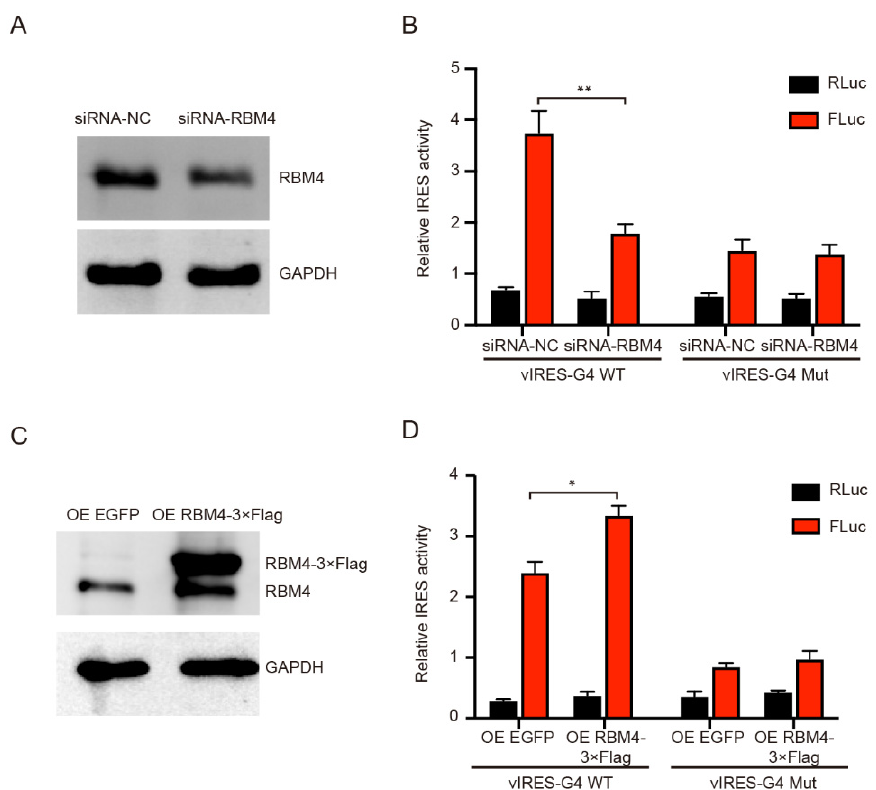
Figure 4. Effect of RBM4 on the expression of luciferases. ( A ) Western blot analysis of RBM4 protein after RNAi. ( B ) Knockdown of RBM4 inhibited the FLuc luciferase activity. ( C ) Western blot analysis of RBM4 protein after over-expression. ( D ) Over-expression of RBM4 resulted in the increase in the FLuc luciferase activity in the wild type IRES-A element, but not in the mutated element. * indicates significant difference at p < 0.05; ** indicates significant difference at p < 0.01.